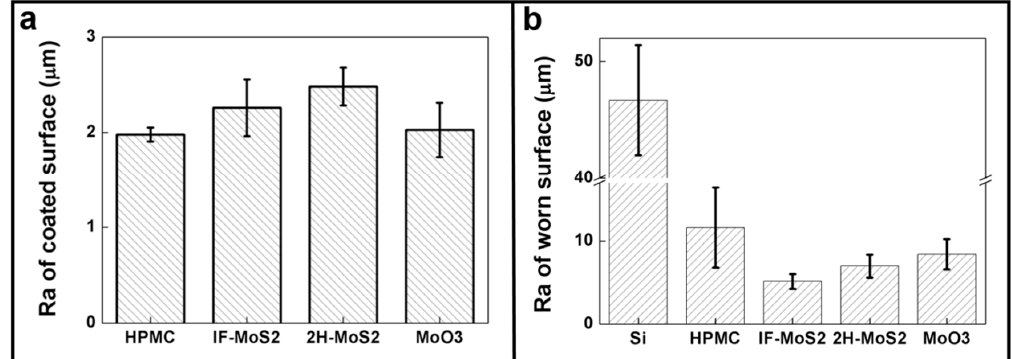
Figure 6. Surface roughness of ( a ) coated surface and ( b ) worn surface after tribotest.